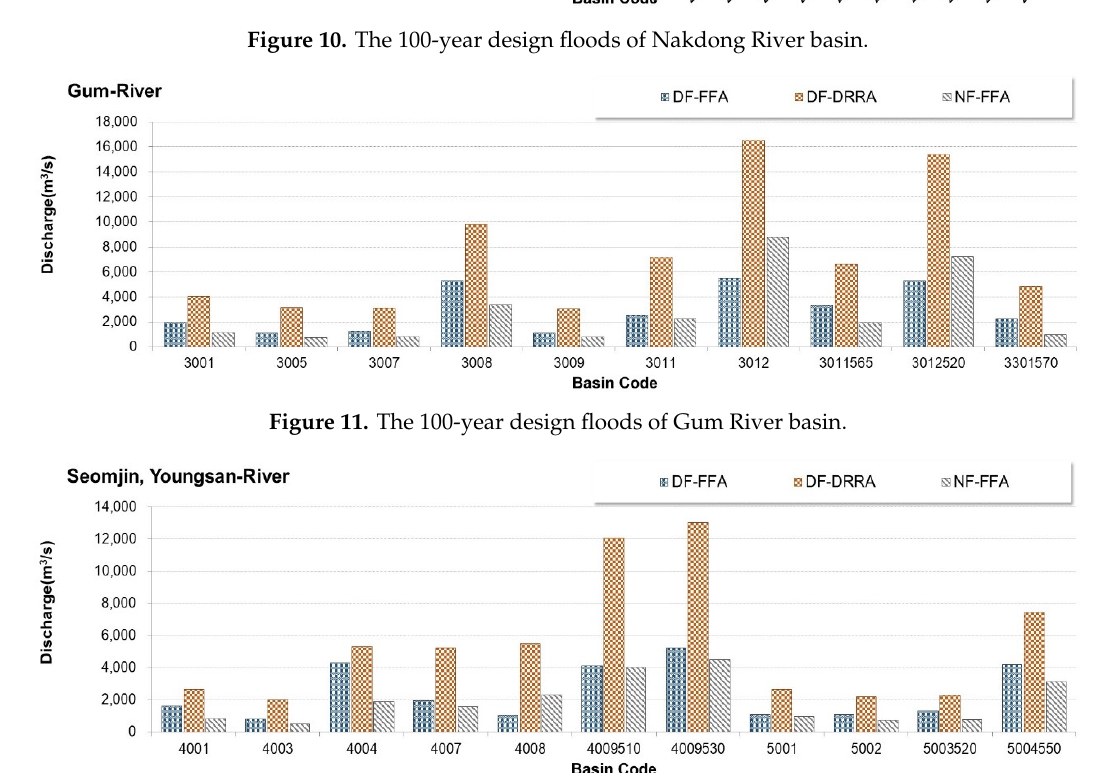
Figure 12. The 100-year design floods of Seomjin–Youngsan River basin.